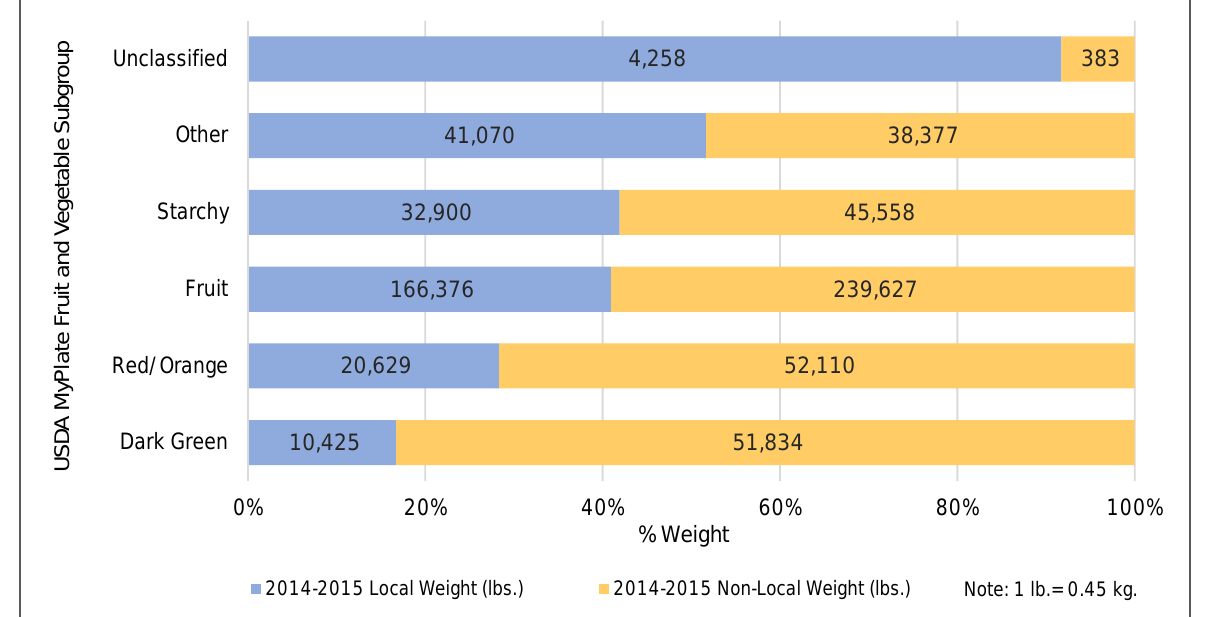
Figure 4. Percent of Weight for Local and Non-local Fresh Food Purchases by Subgroup, Sarasota County